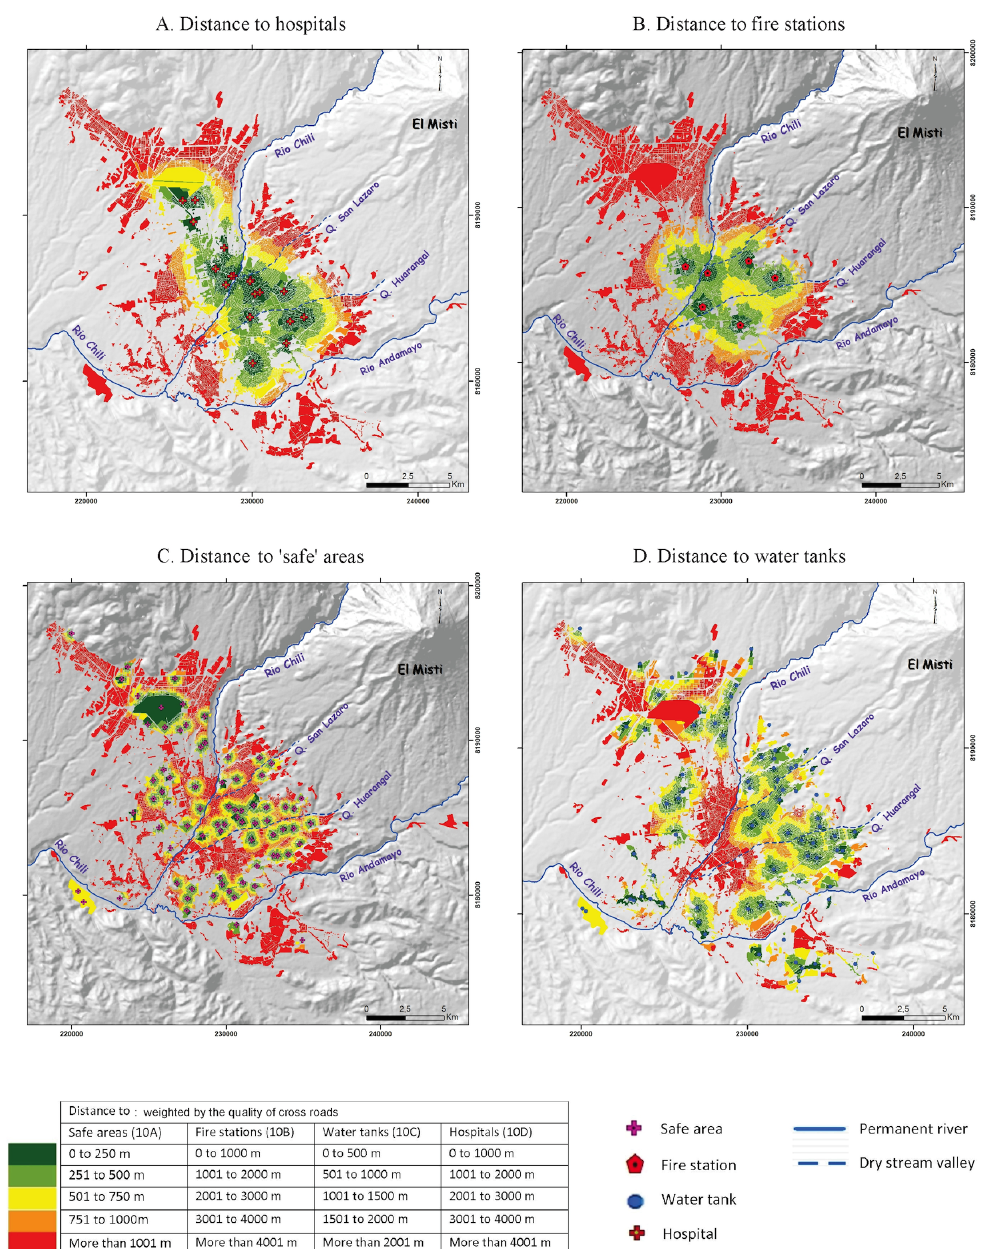
Fig. 10. Distances to hospitals, “safe” areas and water tanks in Arequipa. The figures represent the measure of isolation at the block scale including hospitals (A) , fire stations (B) , and “safe” areas such as parks and playgrounds (C) and water tanks (D) . The resources (hospitals, etc.) were identified using field and aerial surveys. The distance includes five classes for each indicator (see Table 6a). The distance also takes into account the road conditions (Table